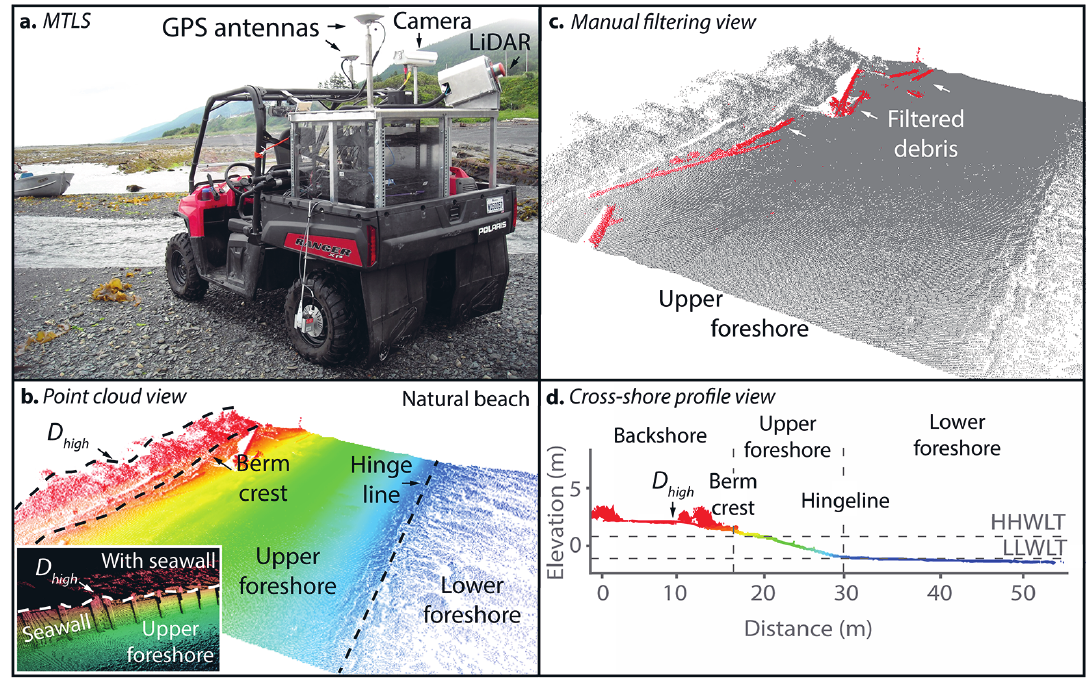
Figure 4. Mobile terrestrial LiDAR system ( a ) with point cloud and filtering